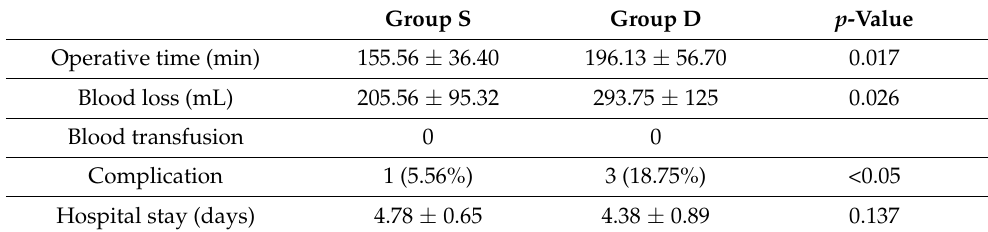
Table 2. Perioperative characteristics.